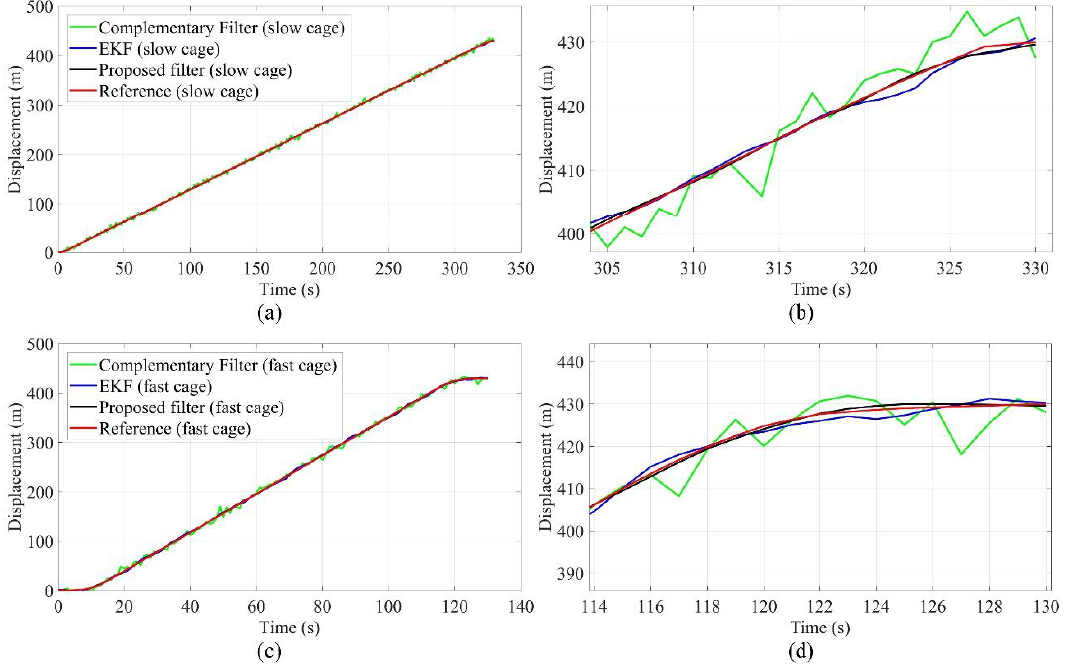
Figure 16. Displacement tracking test of the hoisting cage ( a ) displacement tracking of the slow cage; ( b ) part details of displacement tracking for the slow cage; ( c ) displacement tracking of the fast cage; ( d ) part details of displacement tracking for the fast cage.